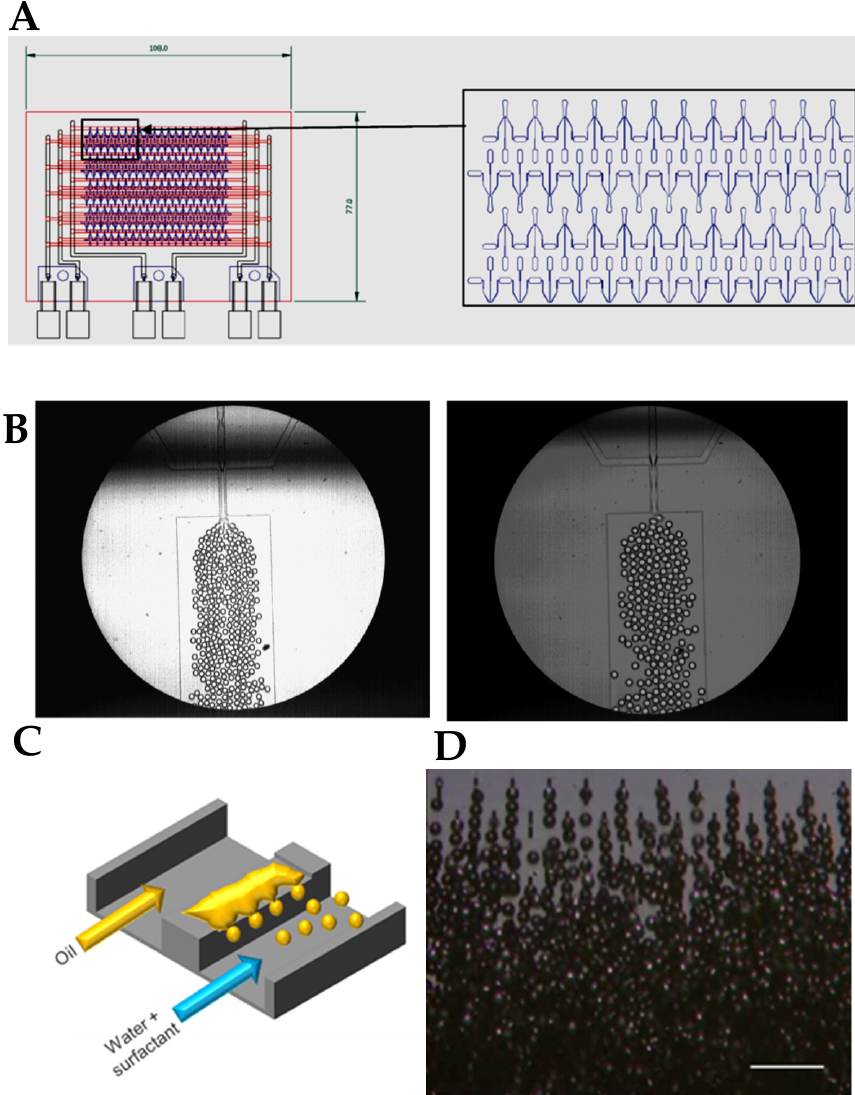
Figure 2. ( A ) Scheme of a PDMS microfluidic platform with parallelization of 20 micro-units for the production of W/O emulsions. ( B ) Droplet generation in two flow rate conditions in a single unit of the microfluidic platform. Adapted with permission from [25]. Copyright (2009) American Chemical Society. ( C ) Schematic representation of EDGE emulsification (reprinted from [29], under the terms of the Creative Commons Attribution 4.0 International license). ( D ) Grooved microfluidic system, picture courtesy of Dr. Kobayashi, Food Research Institute, University of Tsukuba, Japan.